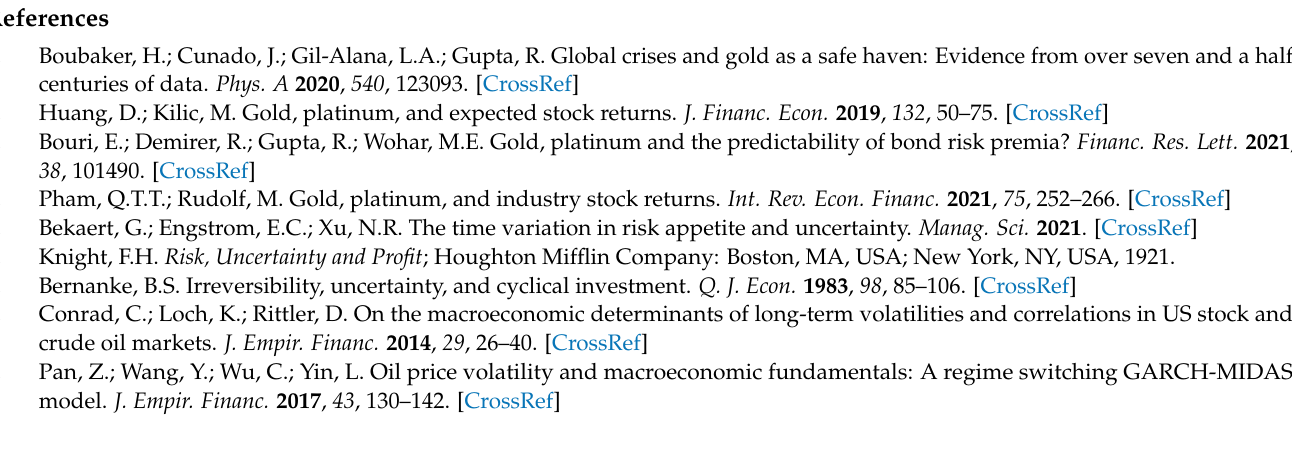
Figure A3. Plot of relative MSFEs from the quantiles-based predictive regression. Note: relative MSFE values less than one in the above figures are indicative of better performance of the model with a predictor (GS or GP), relative to the model without it, across forecasting horizons and conditional distribution of RV. ( a ) Forecasting performance of GS. ( b ) Forecasting performance of GP.